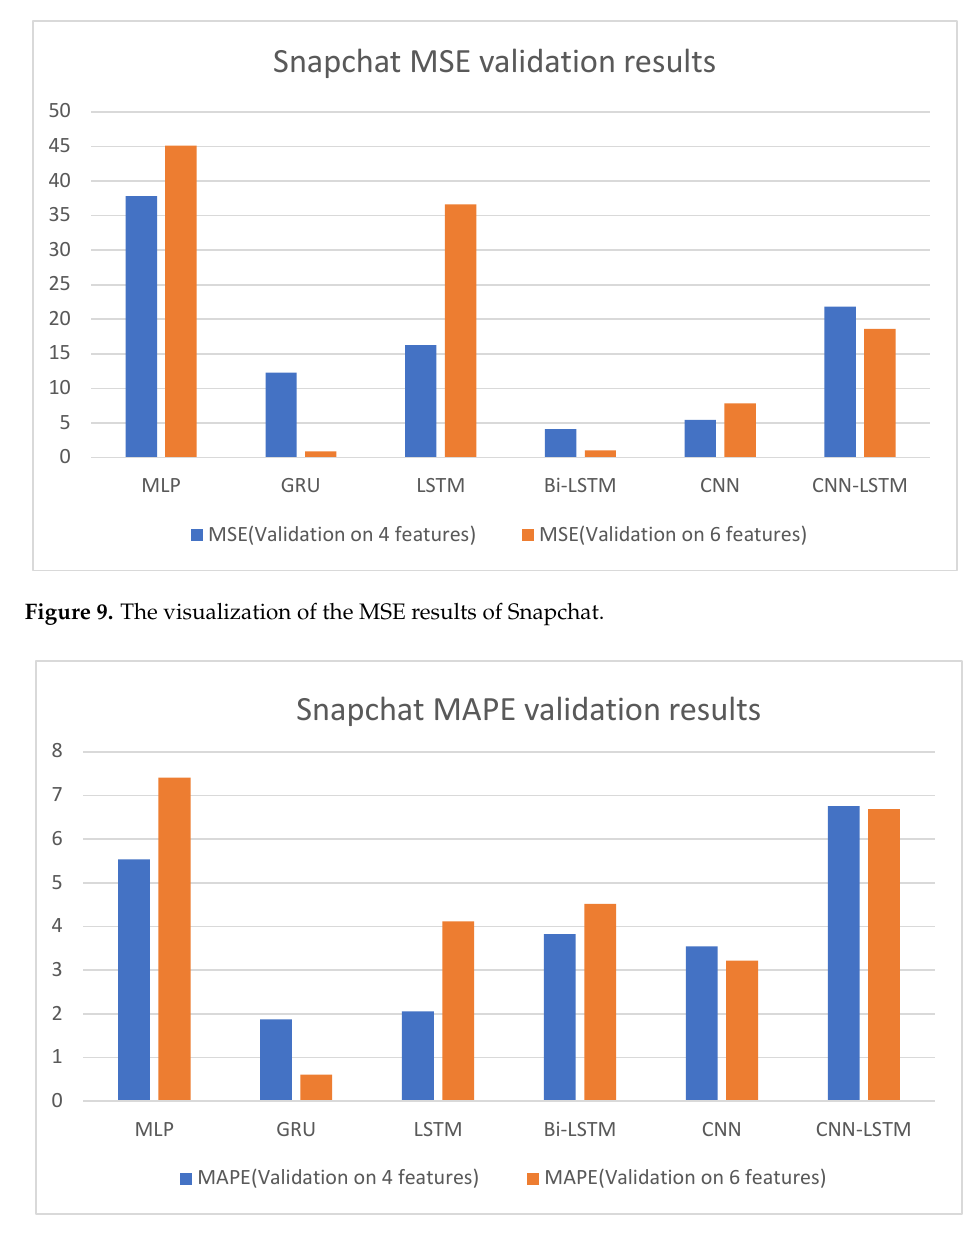
Figure 10. The visualization of the MAPE results of Snapchat .